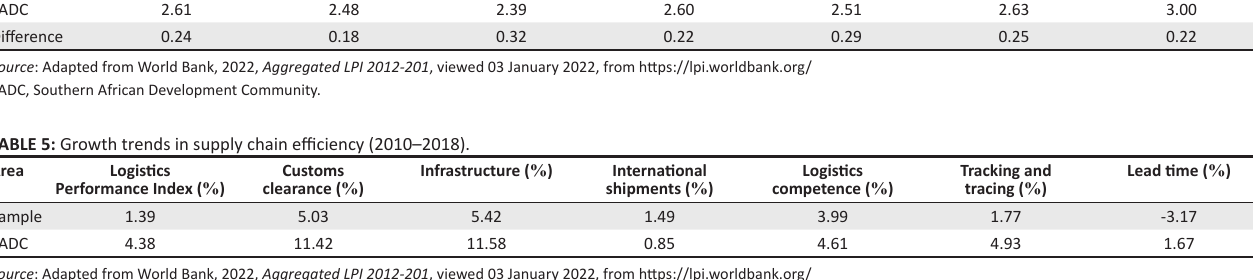
TABLE 4: Comparison of supply chain efficiency and related sub-components (Logistics Performance Index). Area Logistics Performance Index